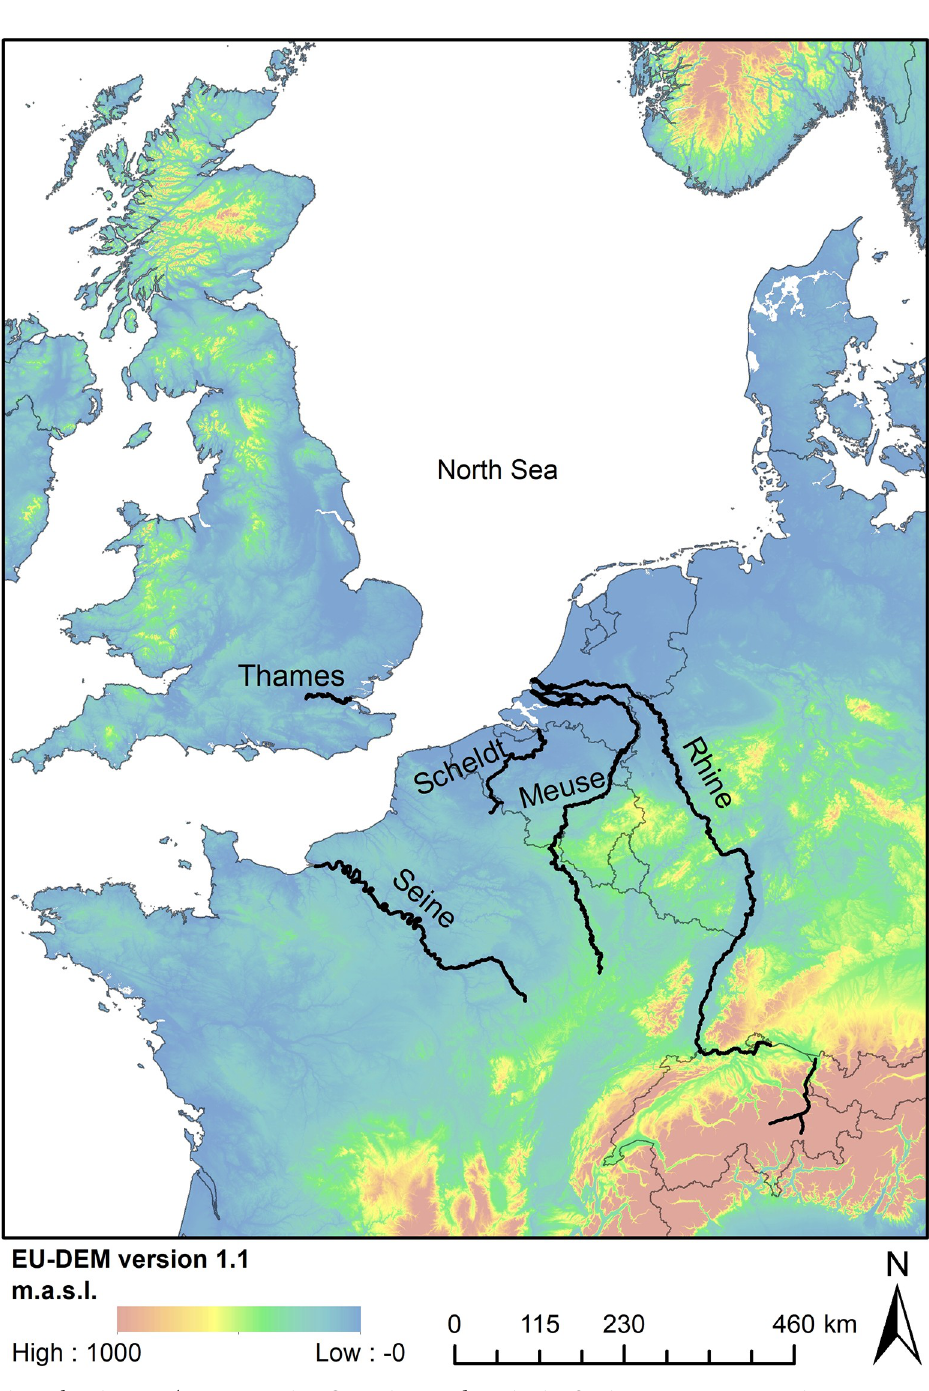
Fig 1. Elevation map (European Union, Copernicus Land Monitoring Service 2019, European Environment Agency (EEA)) with indication of the main rivers in the Rhine-Meuse-Scheldt region.